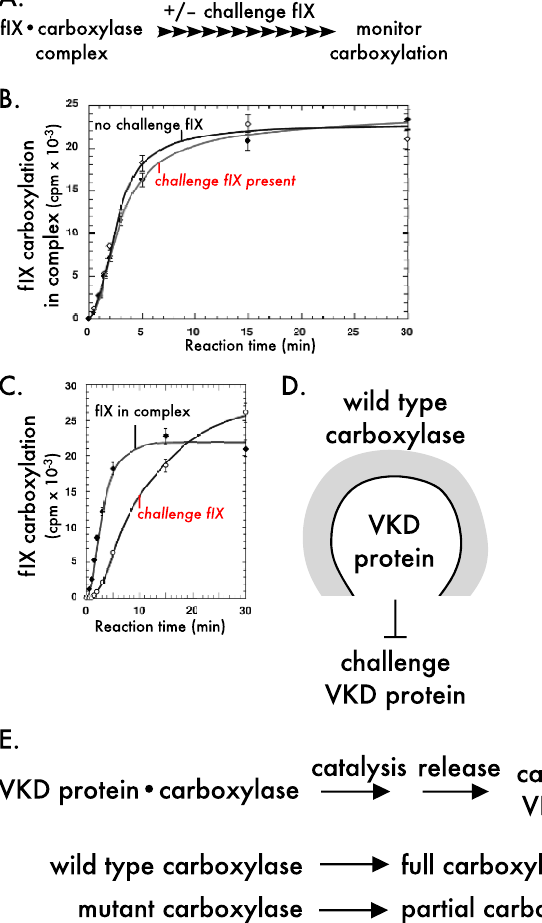
Figure 5. Carboxylase processivity regulates vitamin K-dependent carboxylation. ( A ) To study carboxylase processivity, a complex between the carboxylase and a vitamin K-dependent (VKD) protein is incubated in the presence or absence of a distinguishable VKD protein, and carboxylation of both VKD forms is monitored [16]. The VKD protein in the study was full length factor IX (fIX) attached to the propeptide that mediates complex formation. The challenge protein was the propeptide-containing fIX light chain that has the entire Gla domain. ( B ) Carboxylation of fIX in the complex is the same in the presence or absence of the challenge protein. ( C ) Carboxylation of the challenge protein occurs after carboxylation of fIX in the complex. ( D ) Wild type carboxylase blocks the access of challenge protein during the carboxylation of VKD protein in the complex [16]. ( E ) Carboxylase processivity depends upon the relative rates of catalysis versus release. The time to fully carboxylate the Gla domain is 5 – 6 fold faster than release with wild type carboxylase [15]. A mutant carboxylase with impaired processivity shows similar rates of catalysis and release and generates partially carboxylated VKD protein [15]. Panels B and C are adapted with permission from Stenina et al. [16], copyright 2001 American Chemical Society.